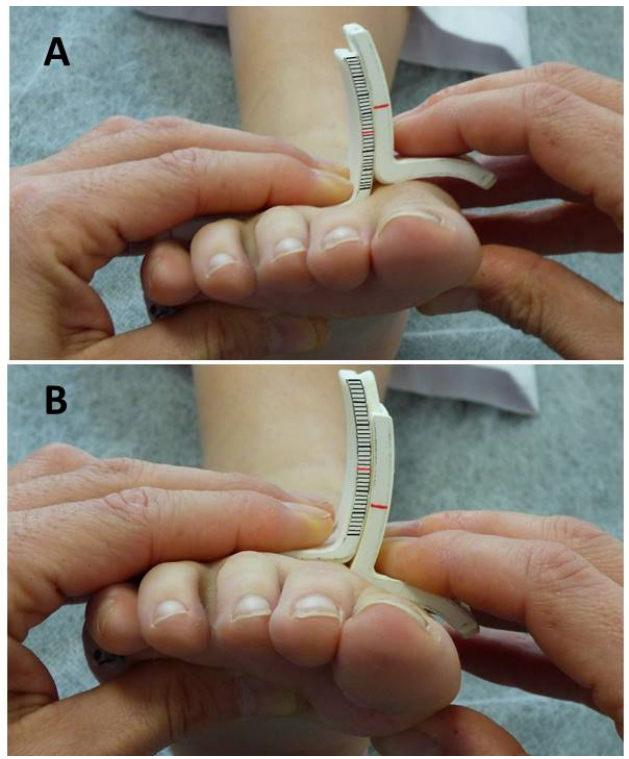
Figure 4. Measurement of first ray dorsiflexion ( A ) and plantarflexion ( B ) with the new instrument.